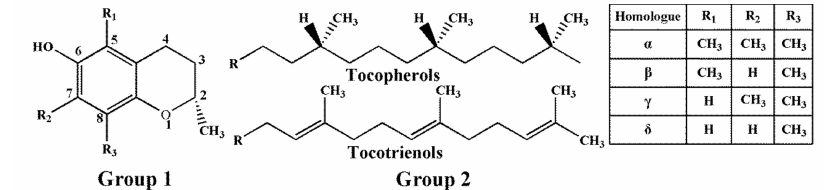
Figure 1. Chemical structures of T and T3. Group 2 (16-carbon phytyl side chain) is attached to group 1 (chromanol ring) at position